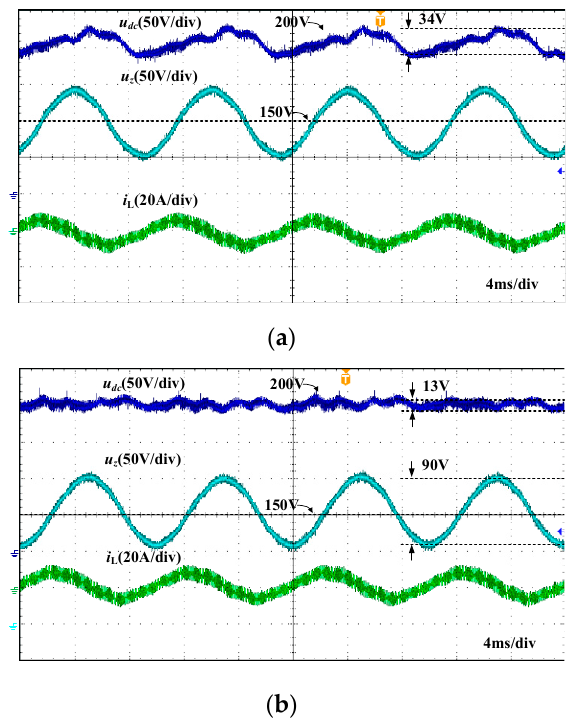
Figure 10. Experiment waveforms of the estimation method and the proposed method at steady state: ( a ) the estimation method; ( b ) the proposed method.